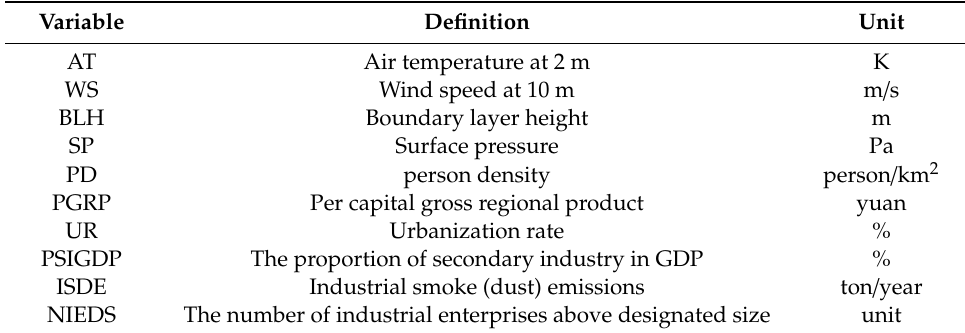
Table 1. Definition of the variables used in the